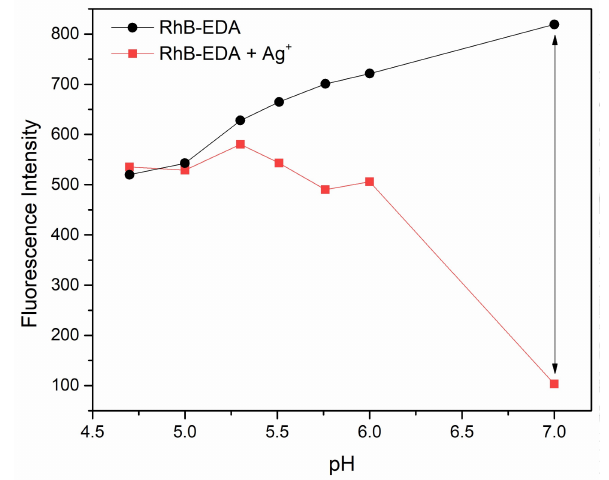
Figure 6. Changes of fluorescence intensity at 538 nm ( λ ex = 500 nm) of RhB-EDA (10 − 4 M) in aqueous solution of MOPS buffer measured with and without Ag + (10 − 3 M) as a function of